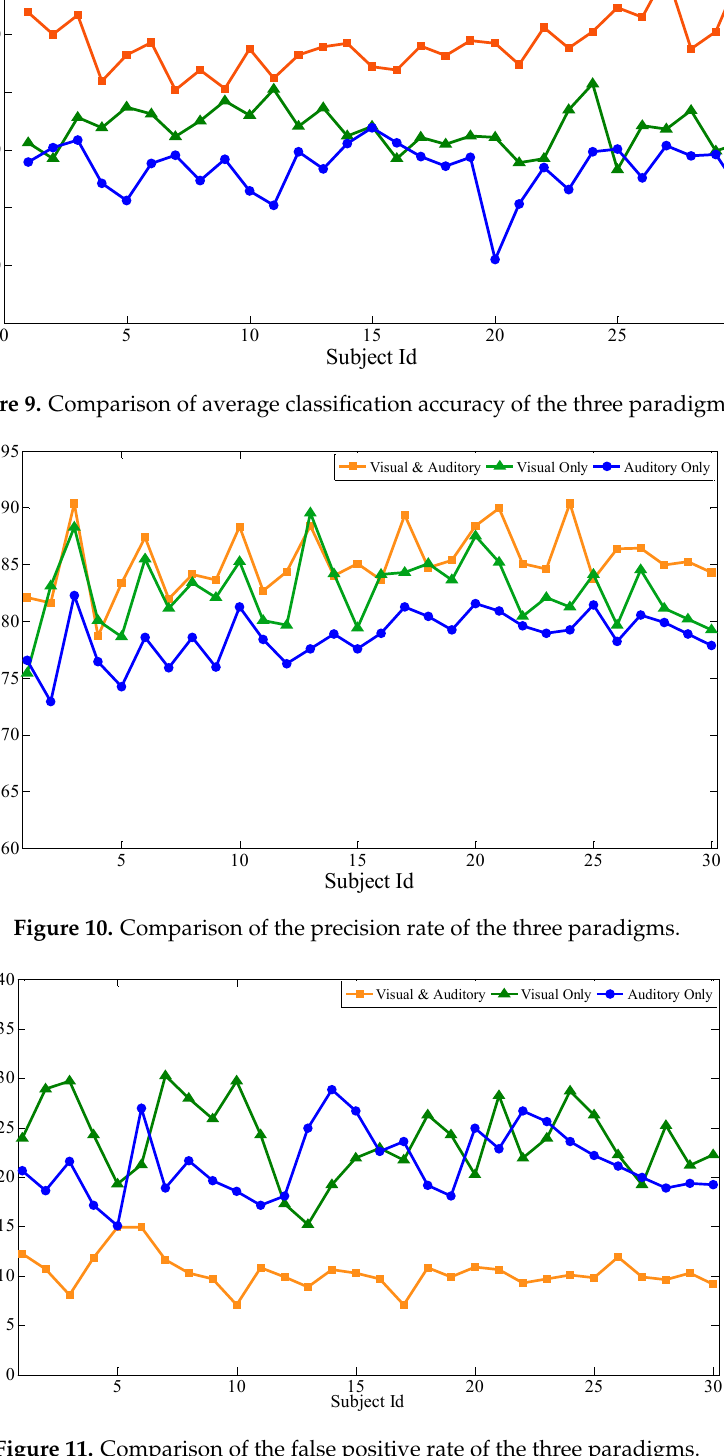
Figure 11. Comparison of the false positive rate of the three paradigms.